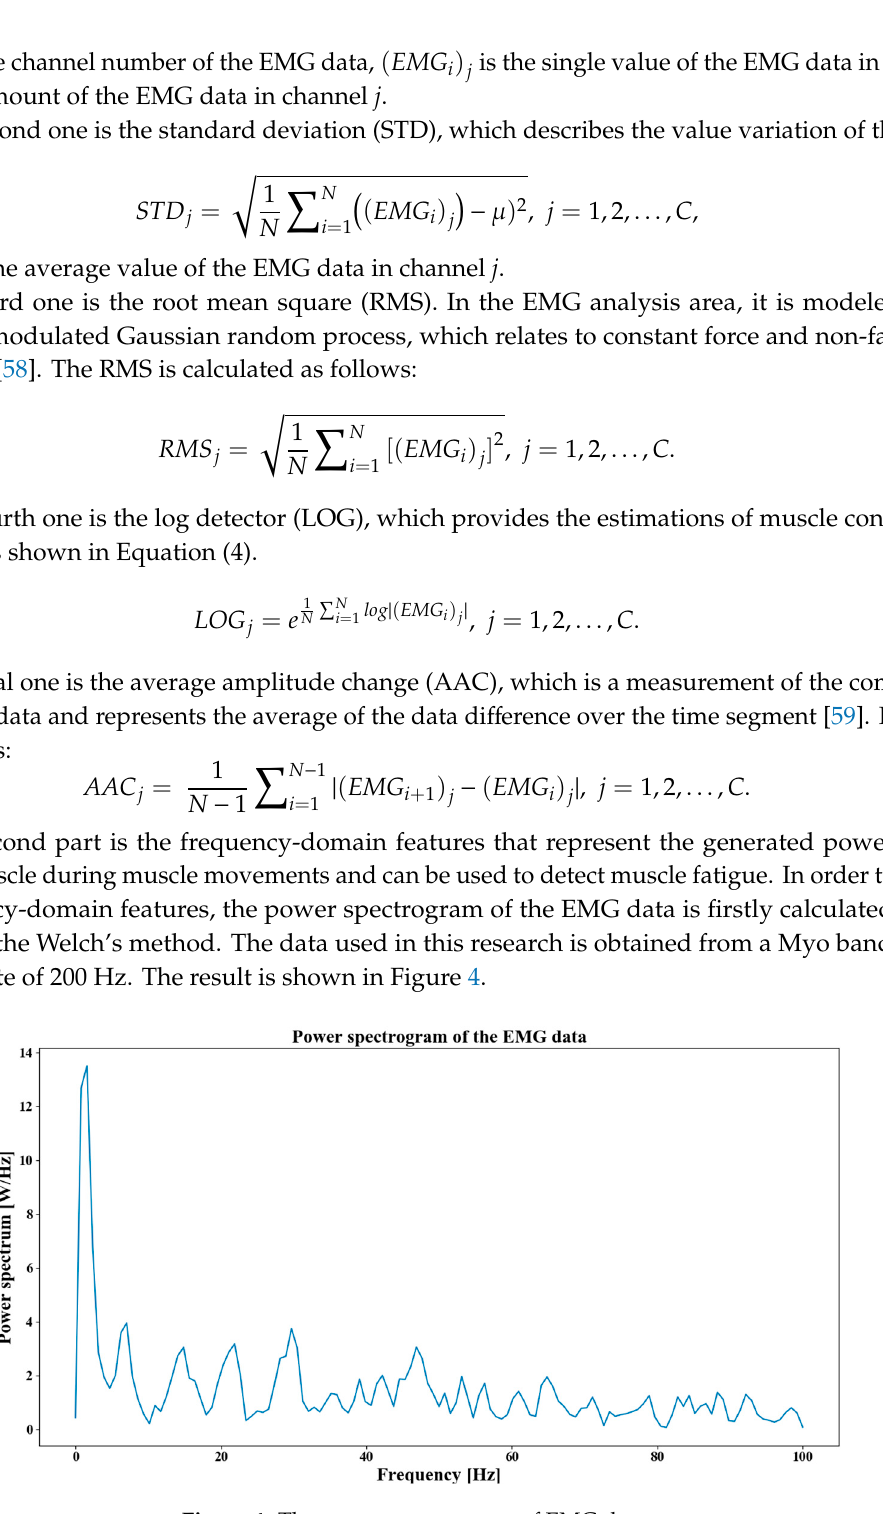
Figure 4. The power spectrogram of EMG data.